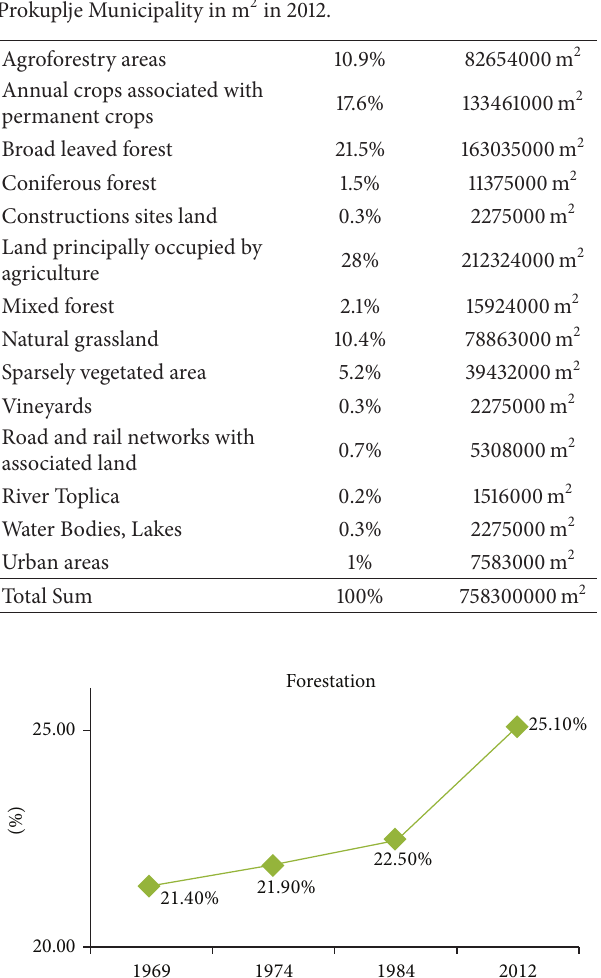
Figure 5: Forestation in the period from 1969 to 2012 for three types of forest: deciduous, conifirous, and mixed, derived from topographic maps (TK 1:25000, Section 582 NIs: 1-4, 3-2, 1-3, 3-1, 3-3, and 3-4, 581 Kursumlija: 4-1, 2-4, 4-2, and 4-4) and from Land Cover Map obtained by using CORINE-like approach in